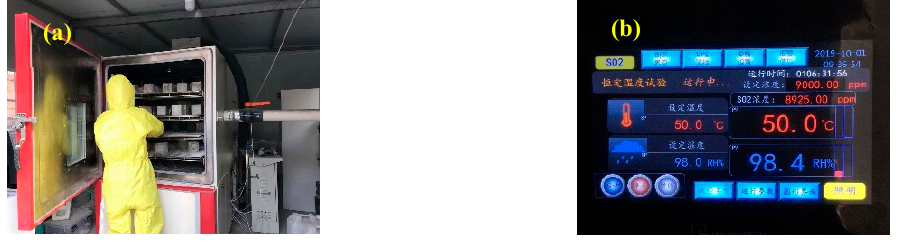
Figure 1. Sulfuration test setup: ( a ) concrete sulfuration test chamber; and ( b ) parameter control panel.